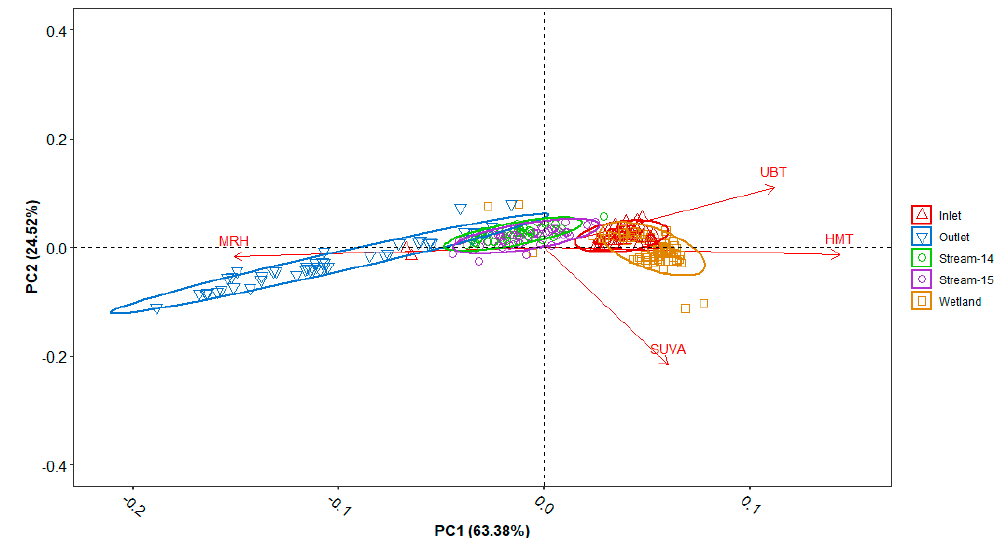
Figure 6. PCA loadings plot and identification similar PARAFAC components overlaid with PCA scores from surface waters at the Arbutus Lake watershed. Confidence ellipses were drawn based on the multivariate t-distribution.